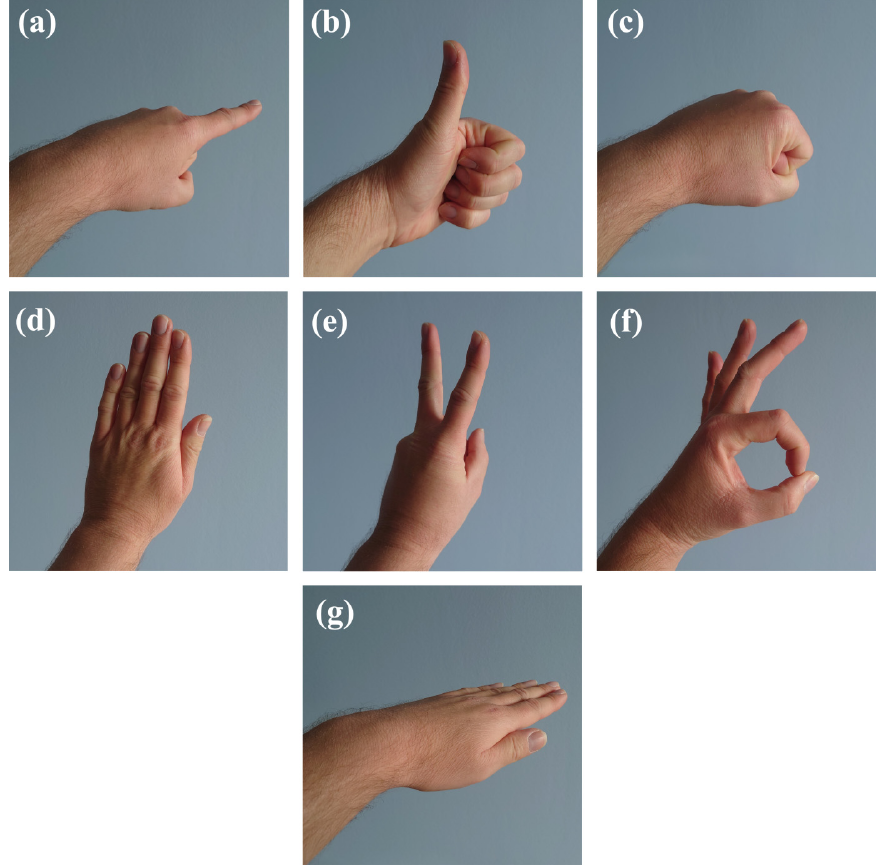
Figure 12. View of the hand when performing gestures: ( a – f ) defined measurement gestures and ( g ) control gesture.